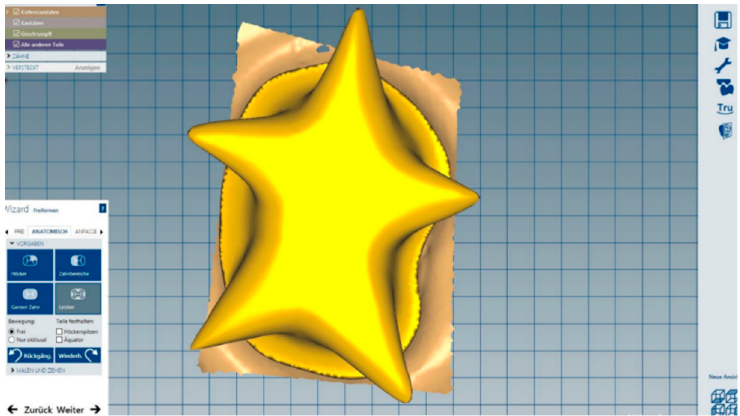
Figure 6. Star-shaped zirconia crown designing using Ceramill Mind software (Amann Girrbach).